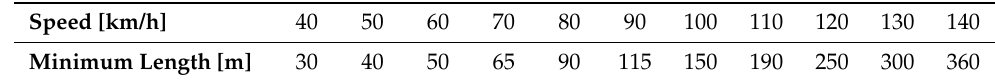
Table 9. Minimum length of tangents based on tangent maximum speed. Speed [km/h]